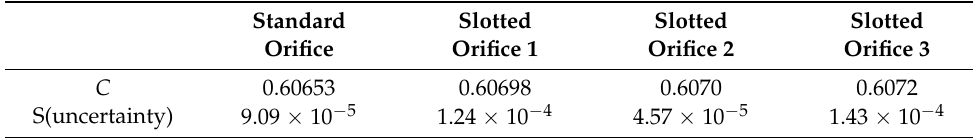
Table 3. Values of discharge coefficient C for investigated